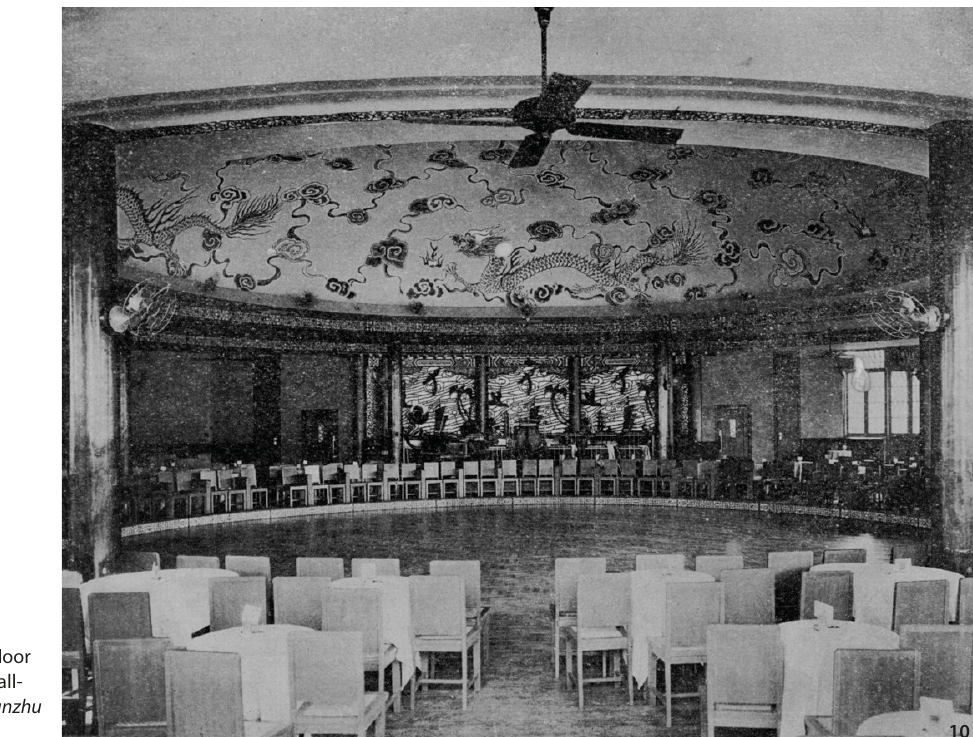
Figure 10 The main dance floor and hall of the Metropole Ball- room (Source: Zhongguo Jianzhu